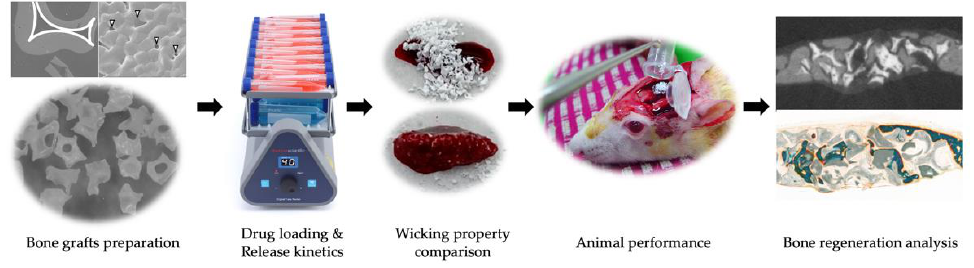
Figure 1. Graphical abstract of the study.